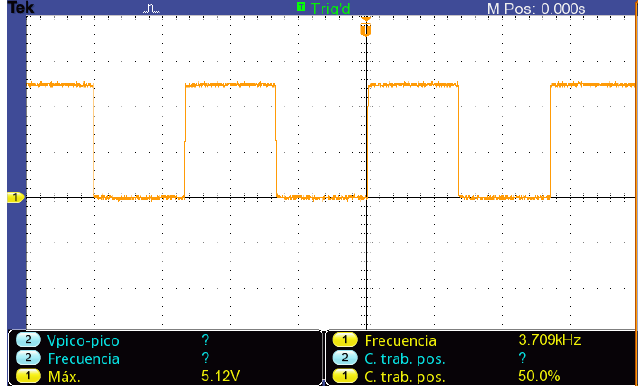
Figure 9. Oscilloscope snapshot for R S equal to 1 k Ω .